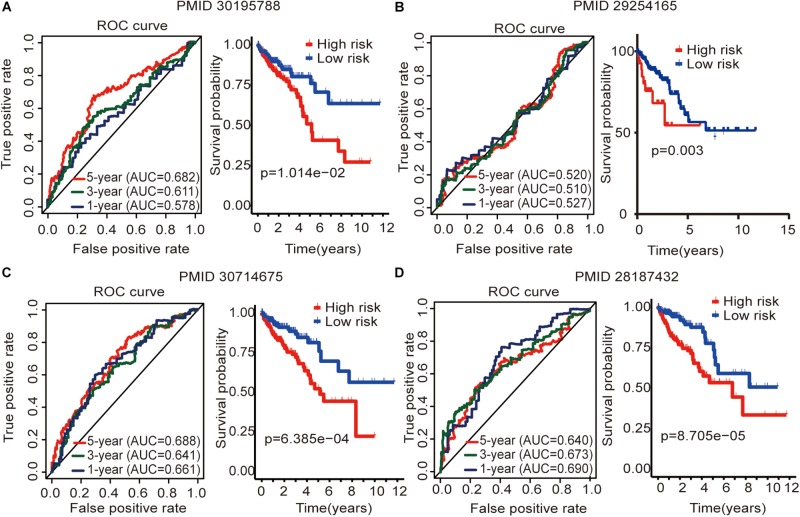
Four lncRNA signatures predict prognosis of colon cancer in the entire TCGA cohort. (A)
Zhou et al. (2018) (PMID30195788) six-lncRNA signature in the entire TCGA cohort. (B)
Xue et al. (2017) (PMID29254165) two-lncRNA signature in the entire TCGA cohort. (C)
Zhang et al. (2019) (PMID30714675) five-lncRNA signature in the entire TCGA cohort. (D)
Zeng et al. (2017) (PMID28187434) four-lncRNA signature in the entire TCGA cohort. The AUC value of the ROC curve is used to evaluate the ability to predict, and the survival curve is used to analyze the difference in prognosis between the high and low expression groups.